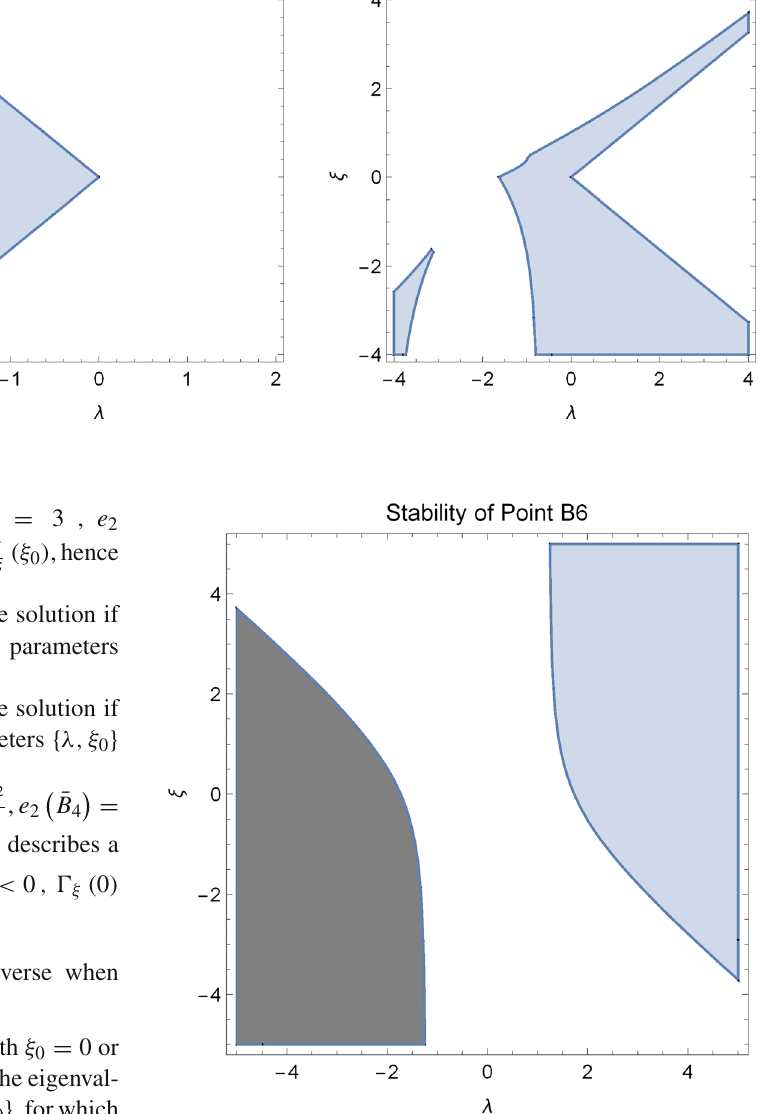
Fig. 10 Region plots for the variables { λ,ξ } in which point ¯ B 5 is an attractor. The blue area is for ξ 0 (cid:14) (cid:8) ξ (ξ 0 ) ≥ 0 while the grey area is for ξ (ξ (cid:14) (cid:8) ) ≤ 0 0 ξ